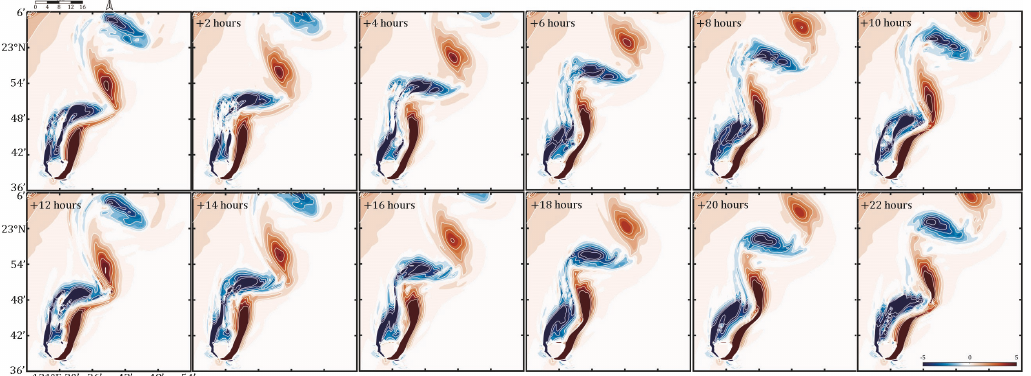
Figure 6. Two different spatially distributed vortices with ( a , b ) Chl-a (mg/m 3 ) and ( c , d ) SST ( ◦ C). Two cases obtained from GCOM-C SGLI data taken at 02:07 (UTC) 27 July 2018 (left) and at 02:04 (UTC) 21 June 2019 (right), ( e , f ) SST and Chl-a values of L1 and L2.